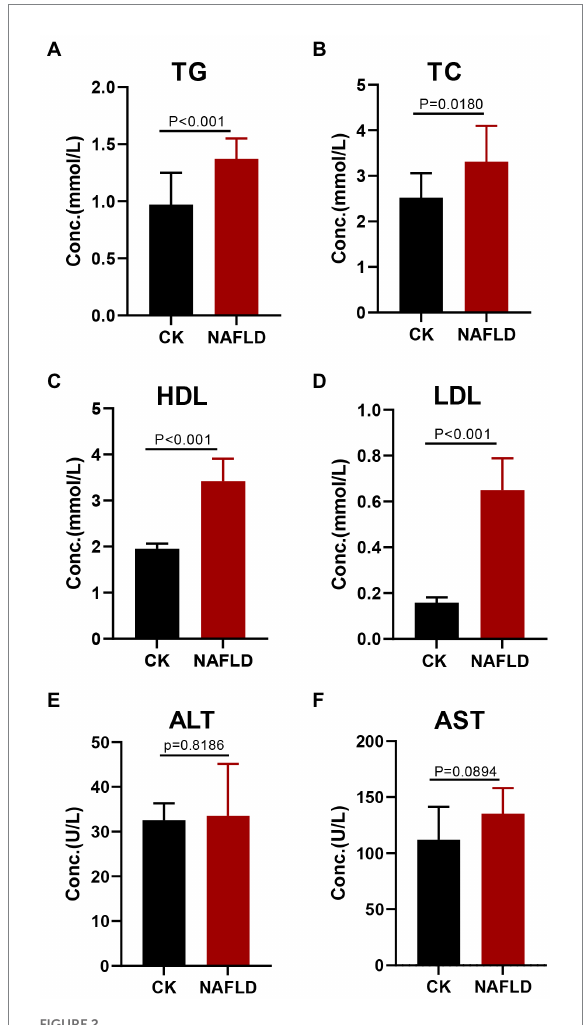
FIGURE 2 Serum lipid profiles and liver function indicators in Control and NAFLD mice. (A) Triglycerides (TG), (B) Total cholesterol (TC), (C) high density lipoprotein (HDL), (D) low density lipoprotein (LDL), (E) alanine aminotransferase (ALT), and (F) aspartate aminotransferase (AST). Significance was assessed by Student t-test